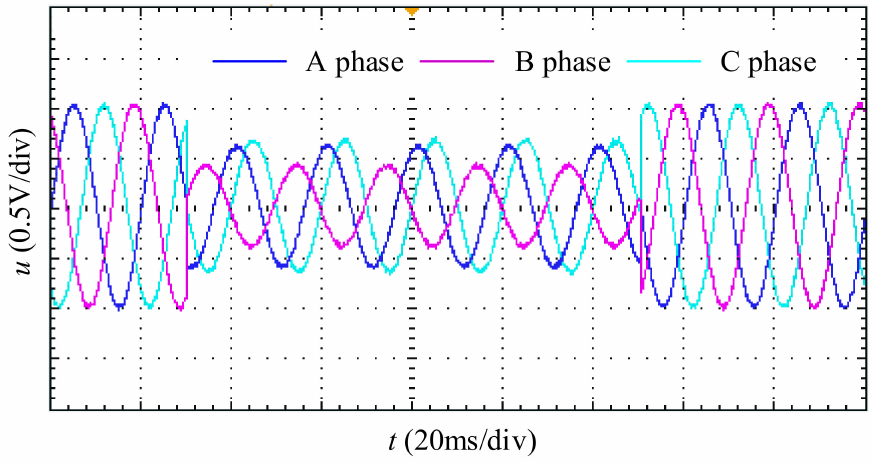
Figure 14. Three-phase unbalance voltage sag drop waveform in hardware-in-the-loop